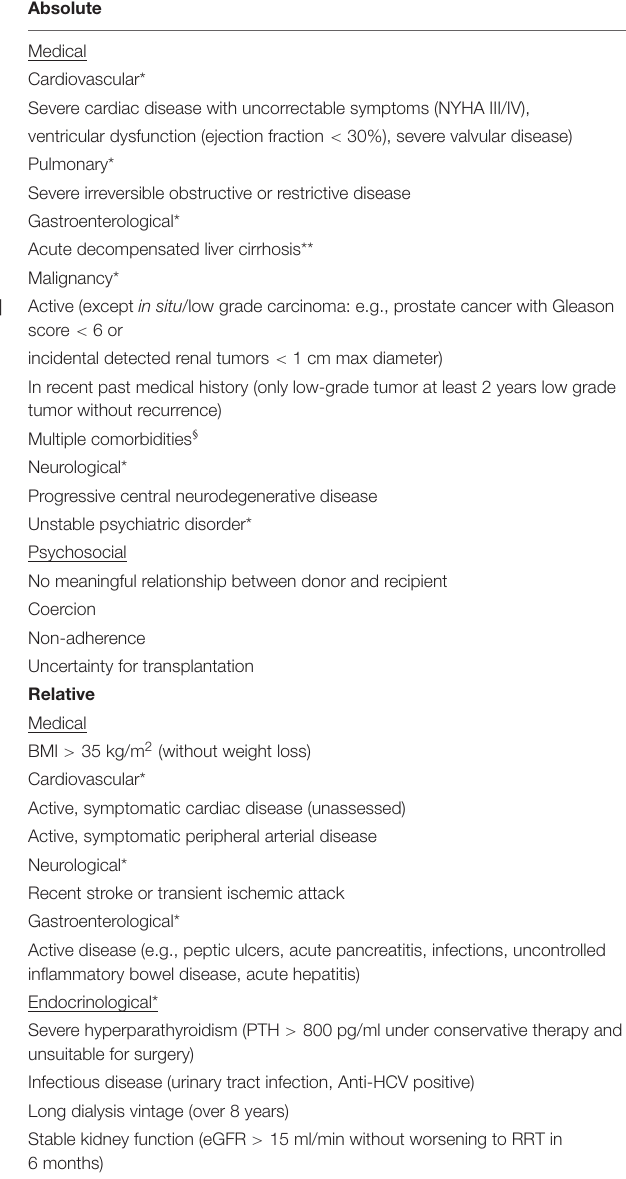
TABLE 1 | Absolute and relative contraindications of potential donors for LKD. TABLE 2 | Absolute and relative contraindications for potential recipients for